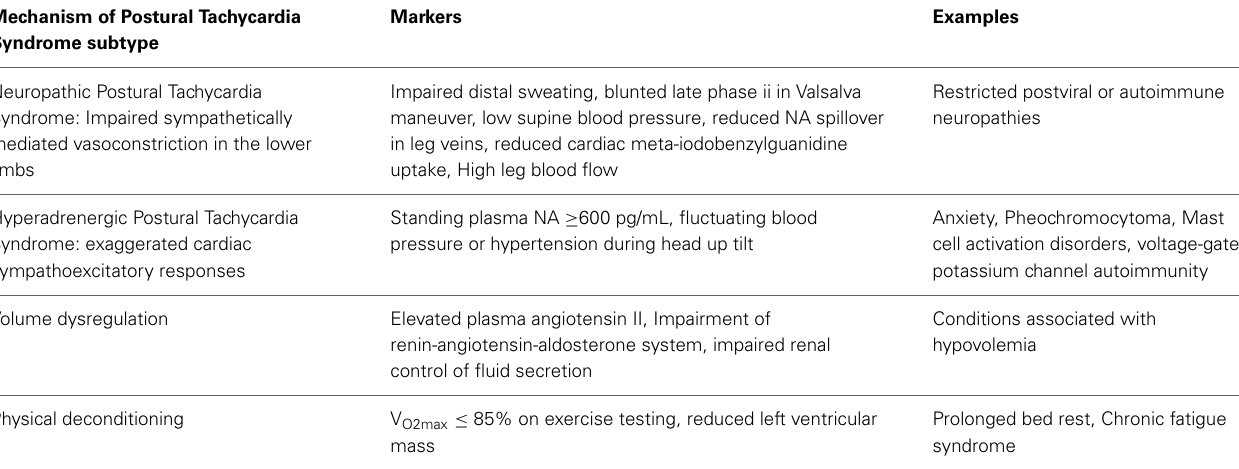
Table 3 | Postural Tachycardia